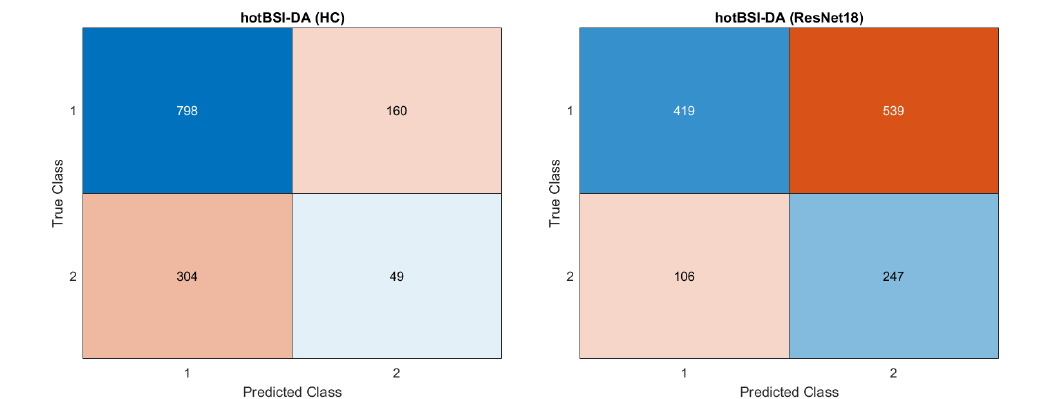
Figure A5. Confusion matrices for the hotBSI-DA trained with handcrafted ( left ) and ResNet18 ( right ) features.